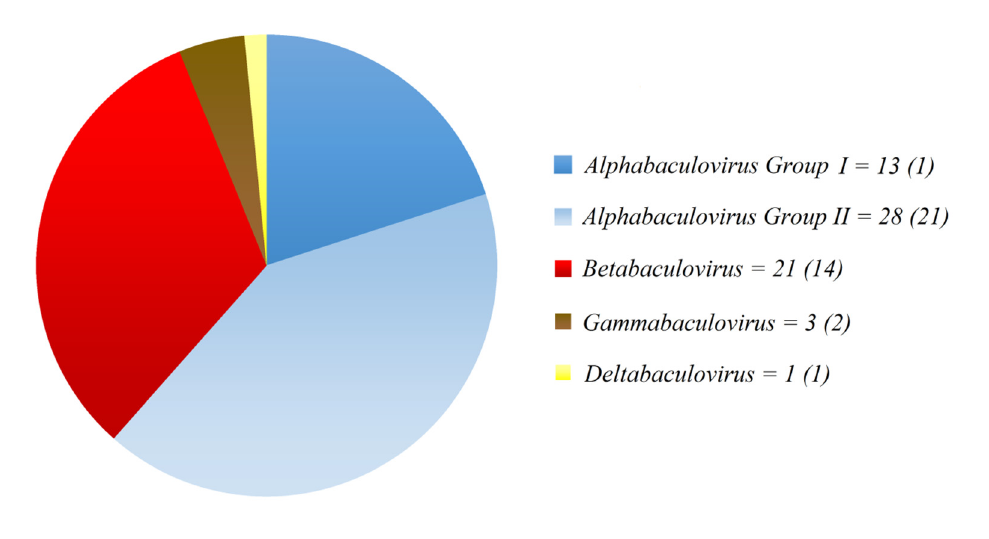
Figure 1. Baculoviridae . The numbers of putative species in each of the four genera